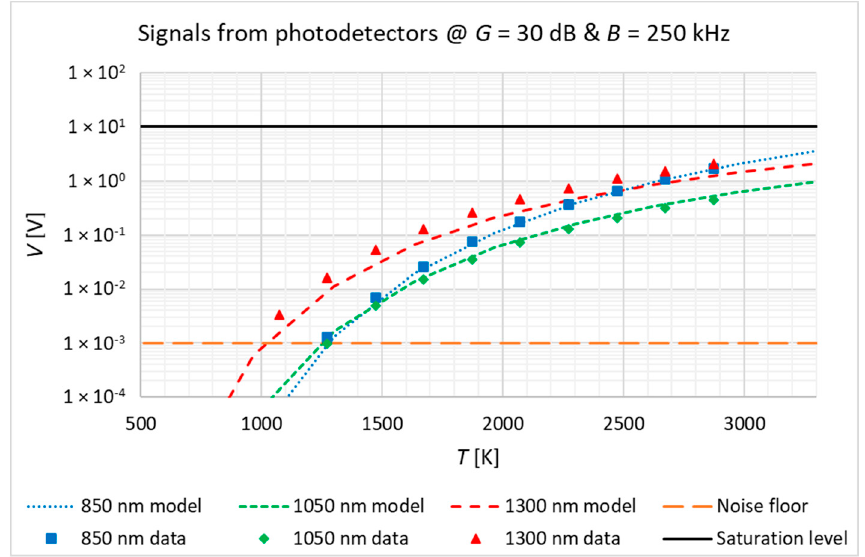
Figure 8. Experimental data compared with theoretical model.